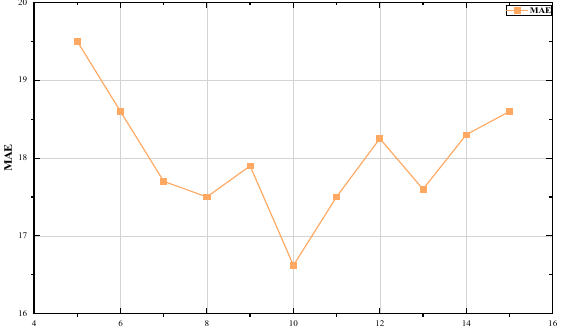
Figure 5. The MAE distribution with different time step.